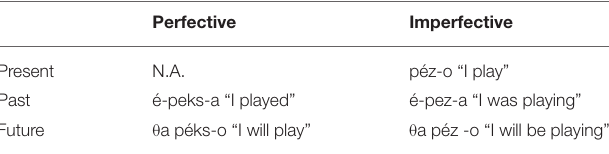
TABLE 1 | Time reference and aspect of the verb pezo “I play” in Greek, with the imperfective stem pez - and the perfective stem peks -.